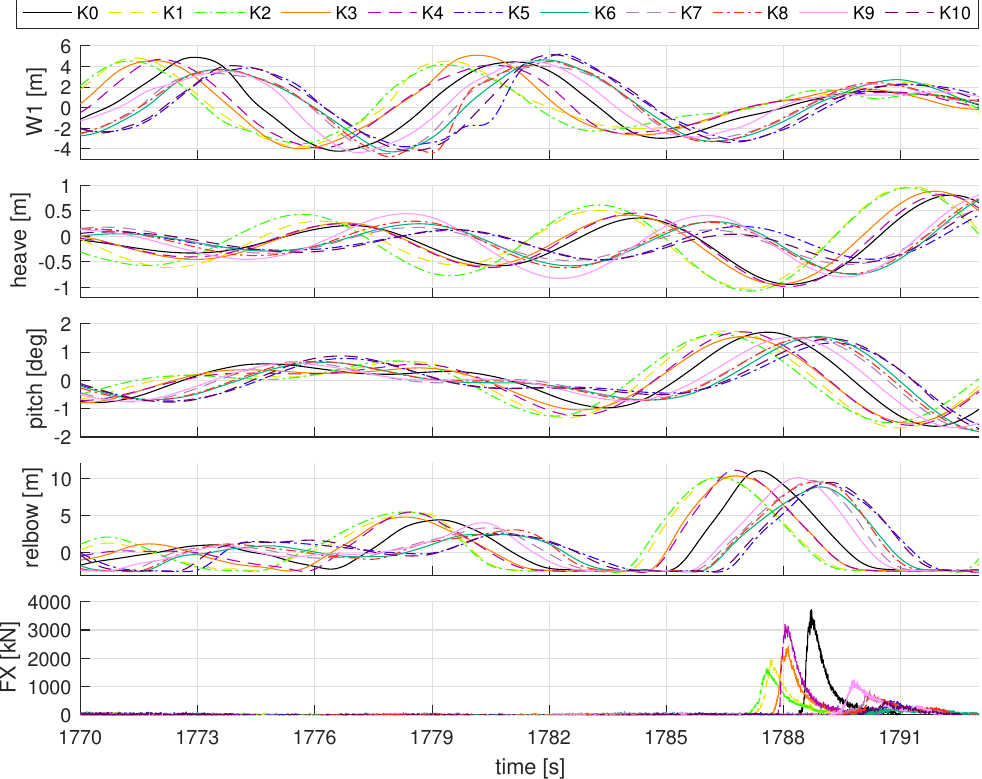
Figure 6. Deterministic repeat runs using synchronised wave generator flap motions with measurement carriage motions, incoming wave (W1, where the strange behavior on some steep wave slopes is caused by the way the acoustic wave probe records a breaking wave), ship motions heave and pitch, relative wave elevation on the bow (relbow) and integrated force on the breakwater (FX) around 4700 m full-scale from the wave generator—similar to a figure in [30], but for a different